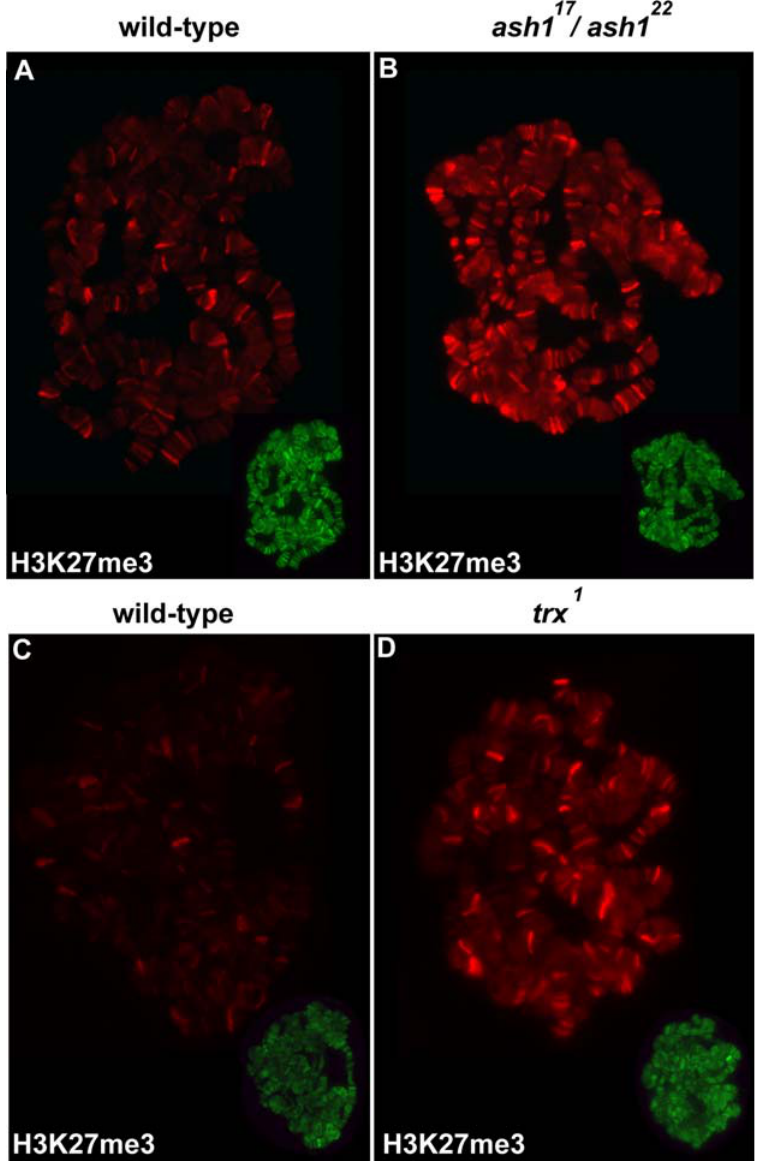
Figure 10. Loss of TRX and ASH1 function also leads to increased H3K27 methylation. The levels of H3K27me3 (A–D, red) on polytene chromosomes isolated from wild-type (A, C), ash1 22 /ash1 17 (B) and trx 1 (D) larvae were detected by double-label indirect immunofluorescence microscopy. H3K27me3 levels are higher on polytene chromosomes isolated from ash1 22 /ash1 17 and trx 1 mutants as compared to wild-type chromosomes. As an internal control, the chromosomes were simultaneously stained with antibodies against the RPB1 subunit of RNA Pol II (inset in lower right corner of A–D, green).